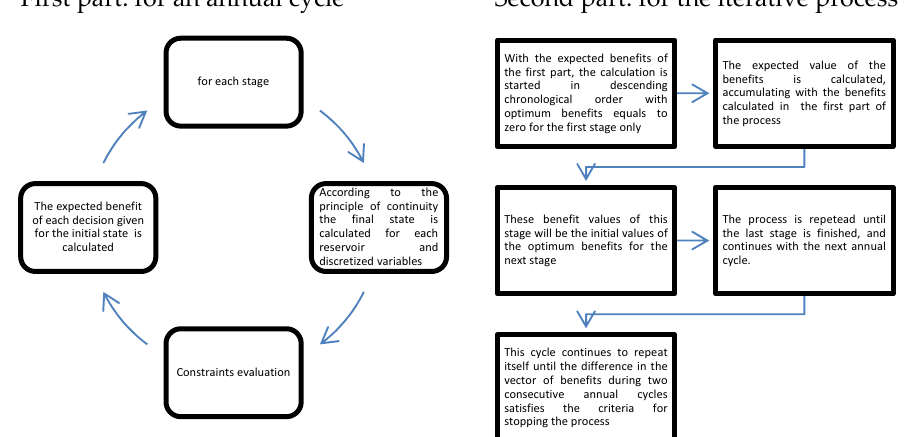
Figure 1. Application scheme of the stochastic dynamic programming algorithm